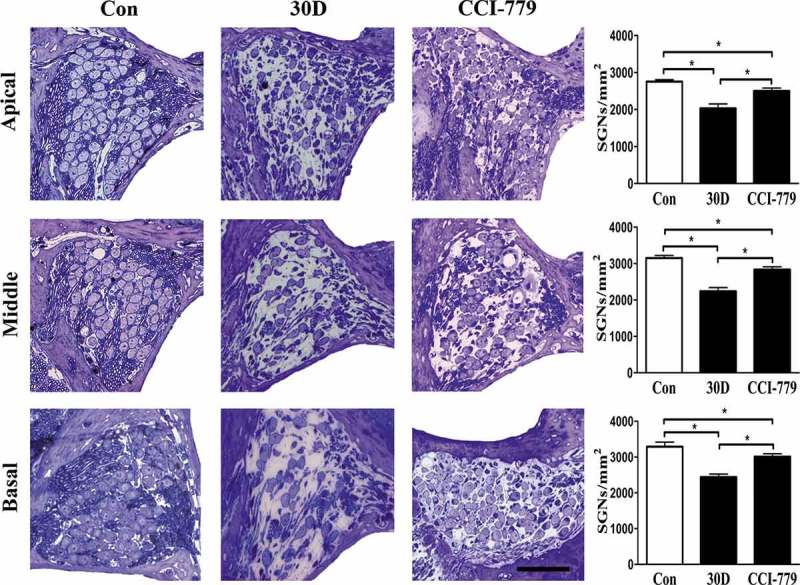
SGN degeneration was significantly attenuated with CCI-779 intervention. Light microscopy observation of toluidine blue staining revealed that SGN density in the apical, middle and basal turn of the experimental group was significantly higher than that of the negative control group but was still lower than that in the blank control group. *, the difference between the 2 groups was significant (P < 0.05); CCI-779, experimental group; 30D, negative control group; Con, blank control group. Scale bar: 50 µm.